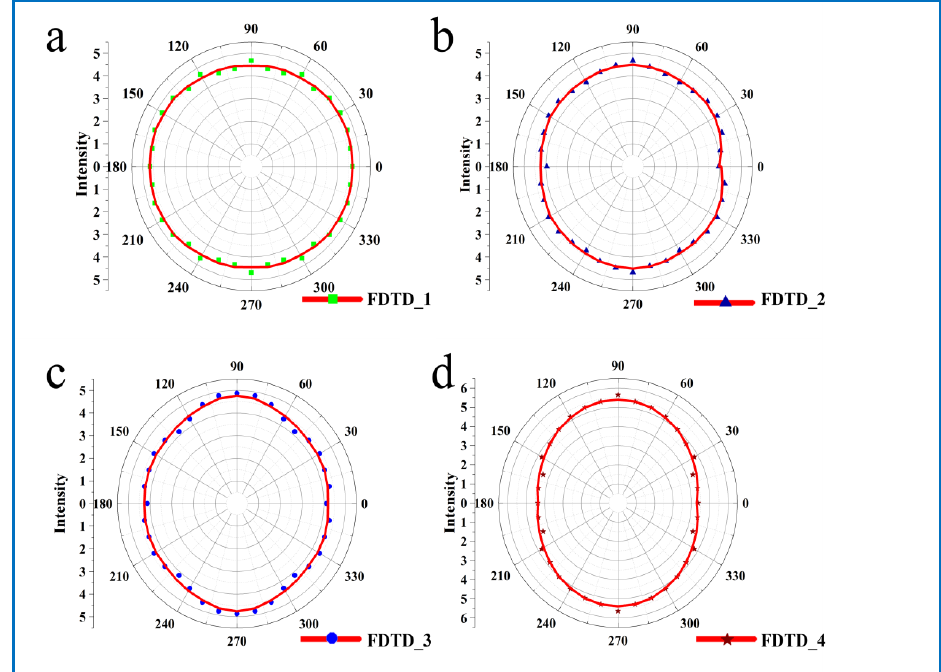
Figure 5. The ( a – d ) are the polarogram of electric field intensity of different polarized light incident at different angles obtained by finite difference time domain (FDTD) simulation of different shapes.